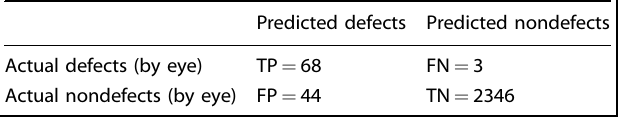
Table 1. A confusion matrix for the prediction of defect sites in Fig.